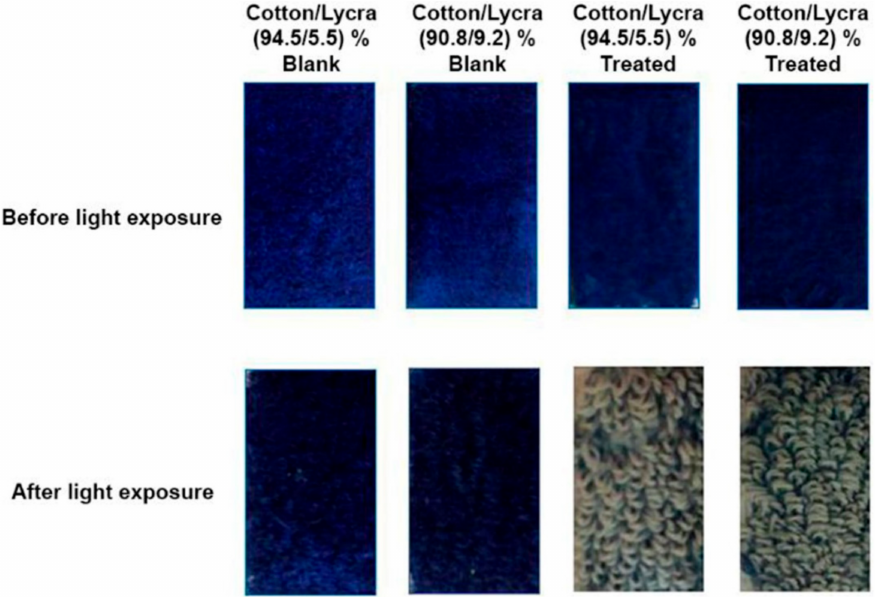
Figure 7. Self-cleaning of the blank and SiO 2 NP/cotton/lycra composite fabrics before and after light